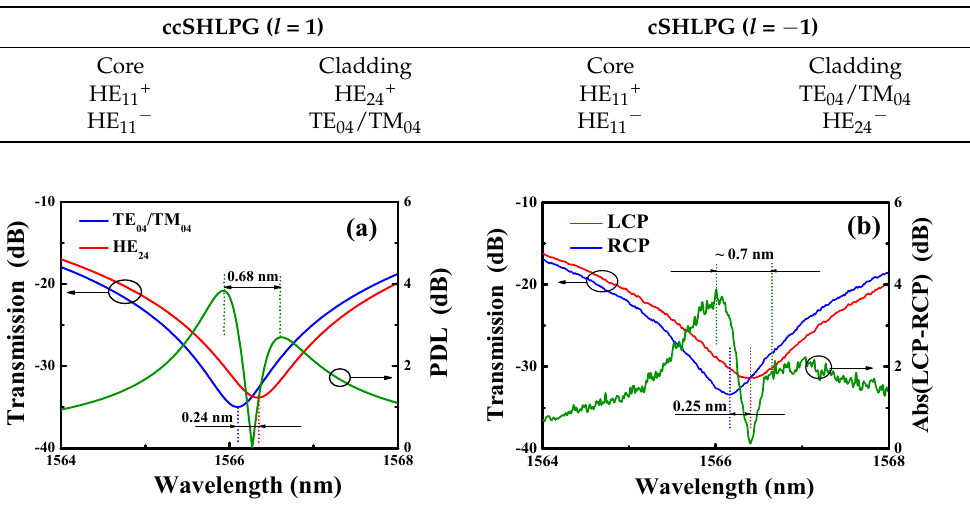
Figure 4. Transmission and PDL spectra of the single-helix HLPG. ( a ) The calculation ones and ( b ) the measured ones. Adapted with permission from Ref. [49] © The Optical Society.